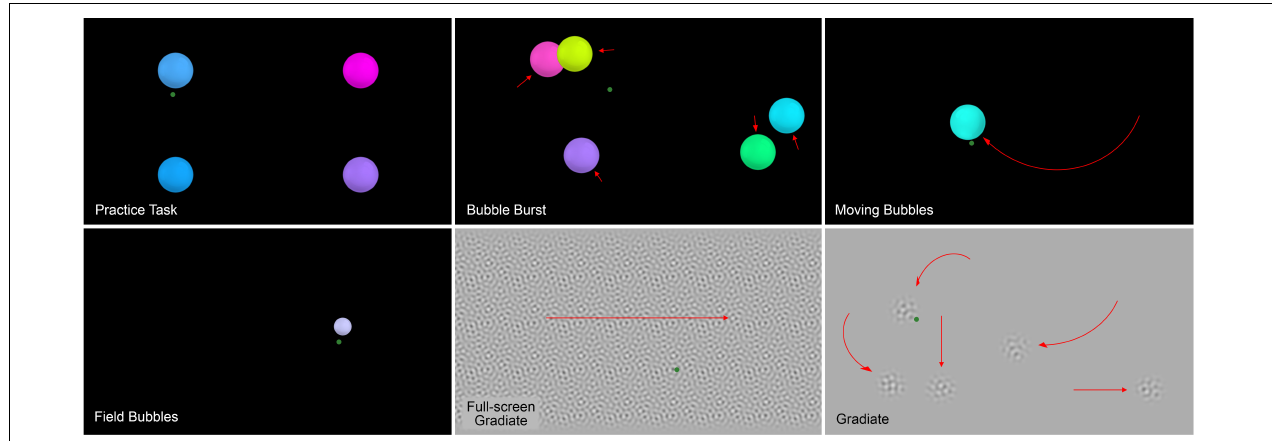
FIGURE 1 | Screenshots of the practice task (top-left) and the five Visual Ladder tasks. The green dots and red arrows represent example gaze points and stimulus motion vectors, respectively, and were not visible to the observer during the